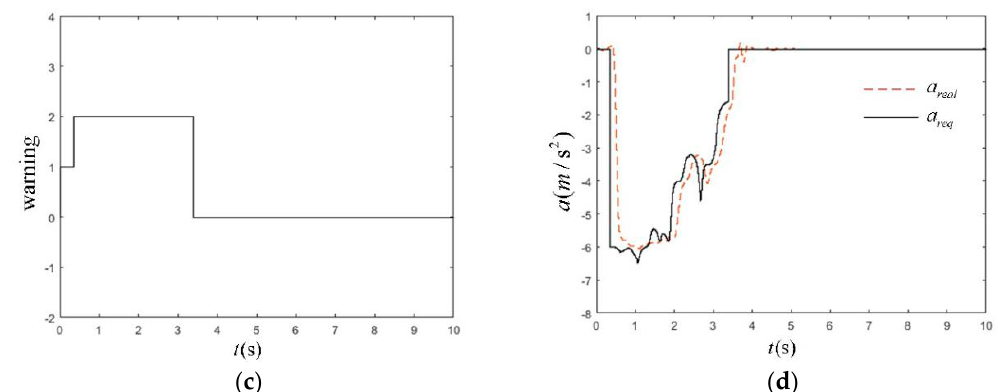
Figure 28. The simulation time as a function of station ( a ), velocity ( b ), warning signal ( c ), deceleration of the vehicle ( d ) in CVNA ‐ 25 scenario at the vehicle speed of 50 km/h.